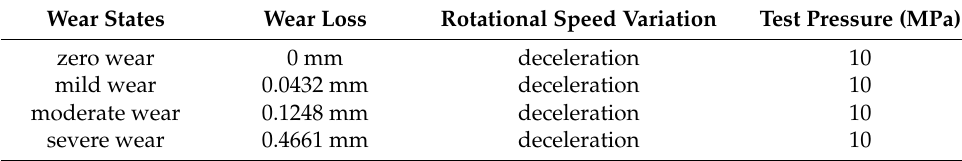
Table 2. Basic parameters of piston pump.